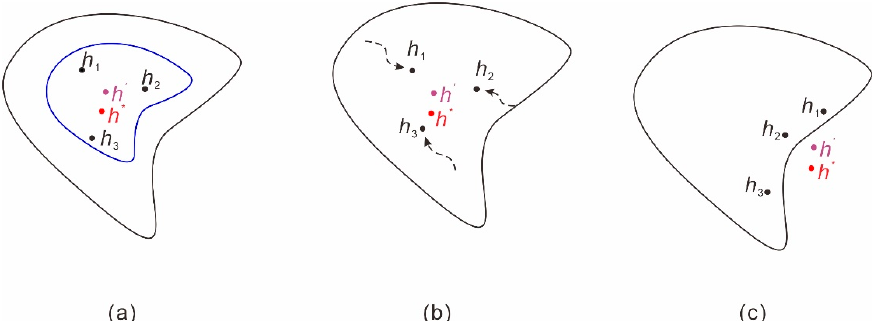
Figure 11. Schematic that shows the fundamental benefits of the ensemble prediction model from statistical ( a ), computational ( b ), and representational ( c ) perspectives. h * is the true prediction model; h 1 , h 2 , and h 3 are single prediction models; and h ’ is the ensemble prediction model obtained by combining the single prediction models h 1 , h 2 , and h 3 . The outer black curve is the hypothesis space of all possible models. The inner blue curve denotes the subset of hypotheses that give reasonable accuracy with the available training data (modified from [47]).